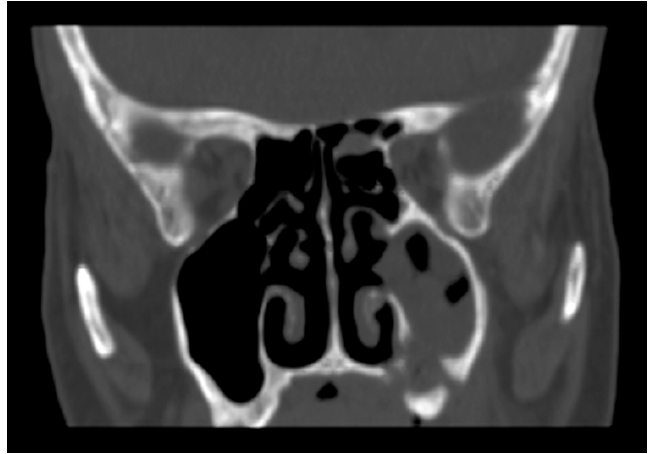
Figure 3. Complete obstruction of the left maxillary sinus with the erosion of the medial wall and floor of the sinus.